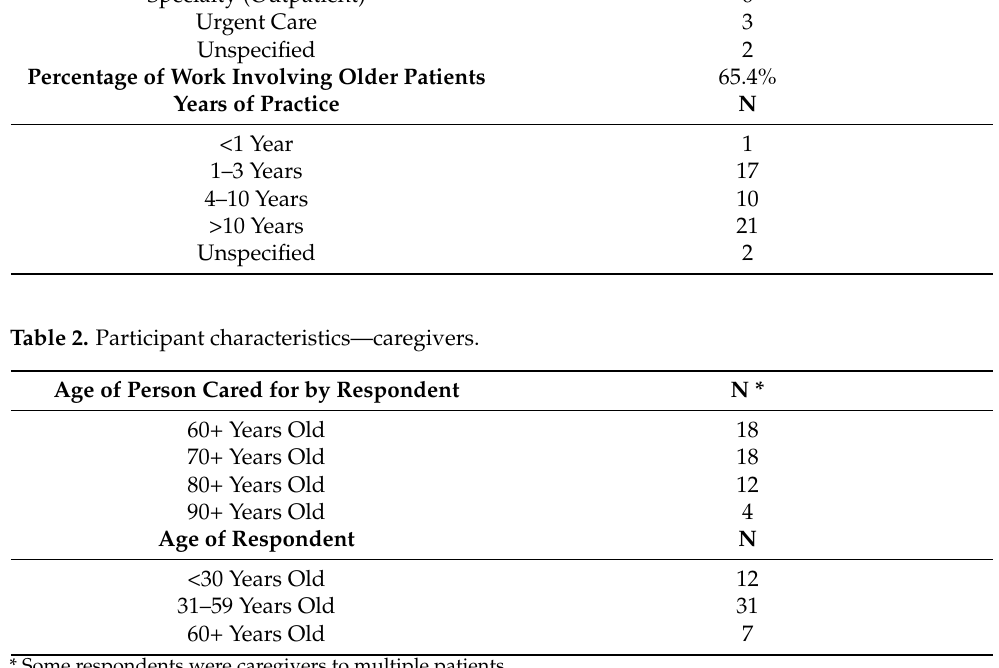
Percentage of Work Involving Older Patients